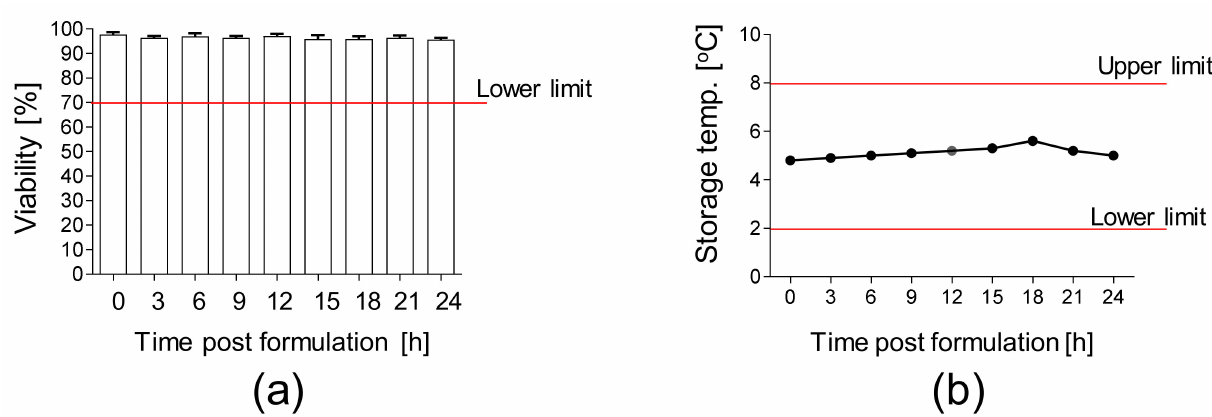
Figure 5. Stability of AT-MSCs solution. ( a ) Viability of AT-MSCs post-product formulation. A total of 10 × 10 6 AT-MSCs were resuspended in carrier solution, transferred into container closure system, and stored at 2–8 ◦ C. Viability of AT-MSCs was measured every 3 h up to 24 h post-product formulation by an automated cell counter ADAM. ( b ) Storage temperature of AT-MSC solution during the stability test. Results are presented as means ± SDs, n = 3 (independent validation